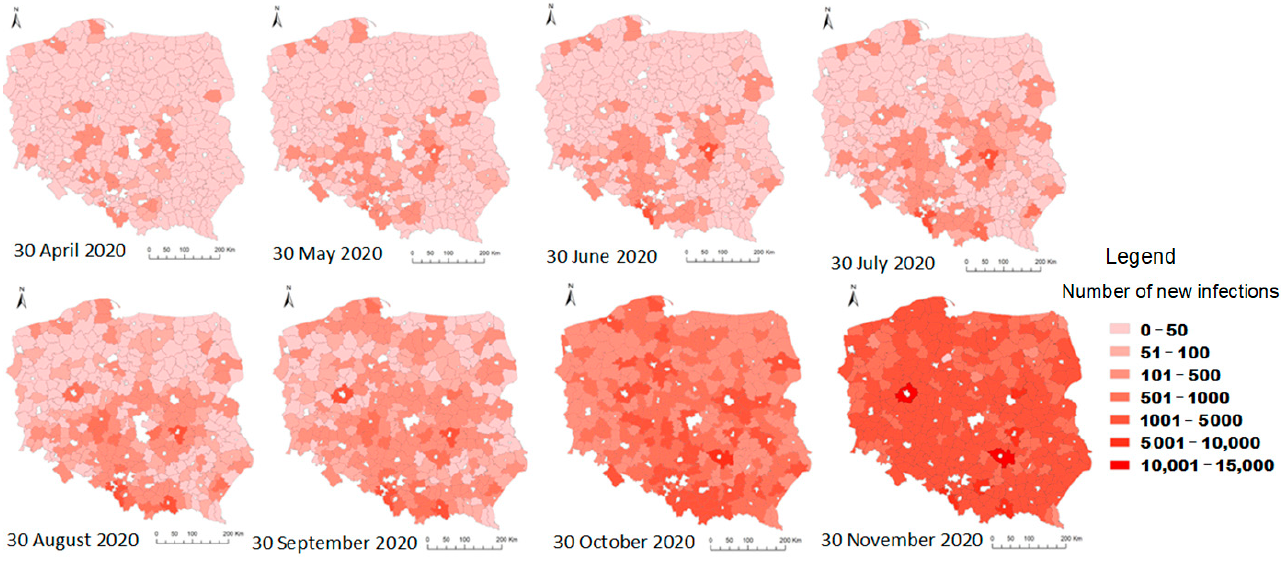
Figure 6. Spread of COVID-19 according to cases registered in Poland from 30 April to 30 November 2020—the first pandemic wave. Source: own